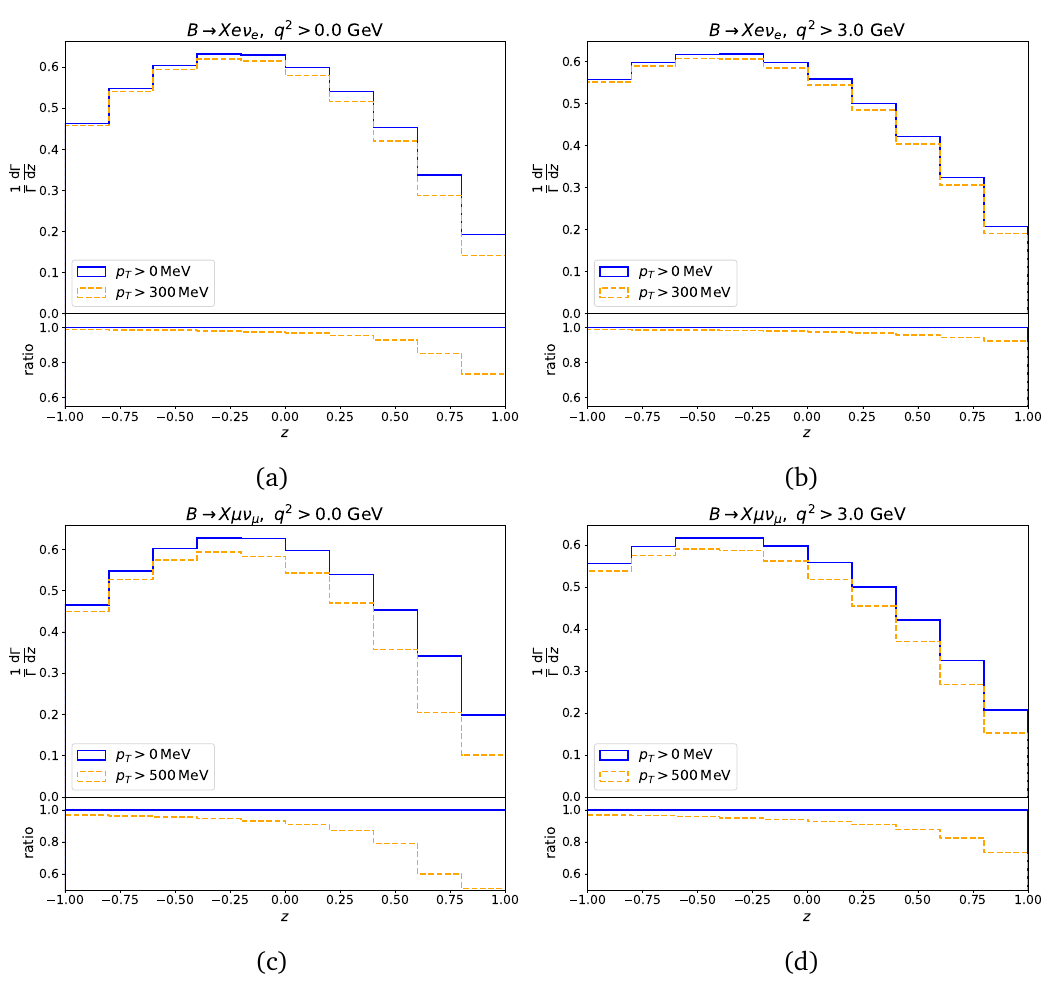
Figure 7: The differential decay rate for B → X l ν ments on the transverse momentum of the lepton in the laboratory frame. The figures in the upper row show the rate for B → X e ν spectively. The figures in the lower row show the rate for B → X µν µ with the same q 2 cuts as for the electron